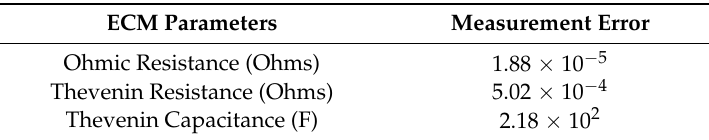
Table 3. The measurement error for the ECM parameters surfaces.